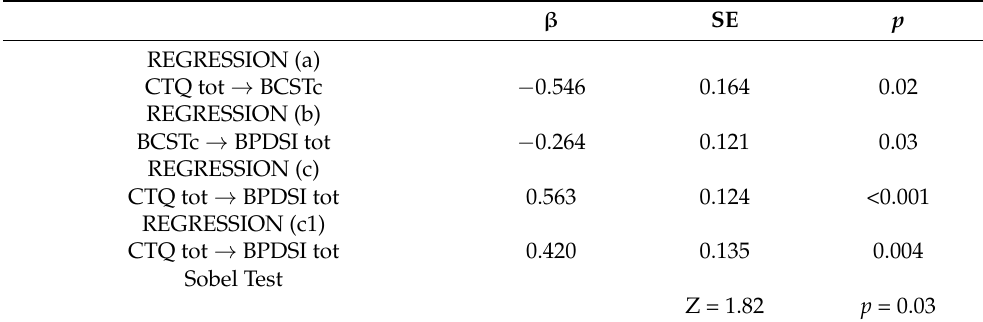
Table 3. Mediational model (M = BCSTc).